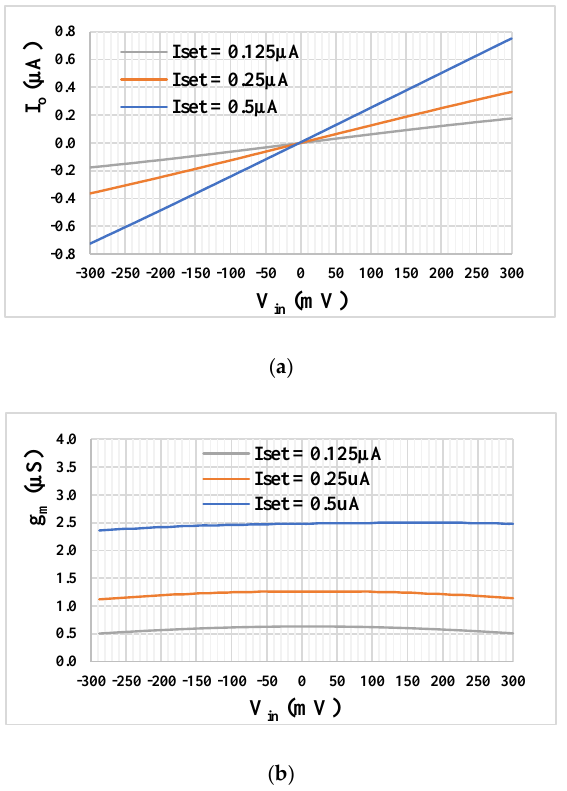
Figure 9. The DC output current ( a ) and transconductance g m ( b ) characteristics of the TA versus input voltage.